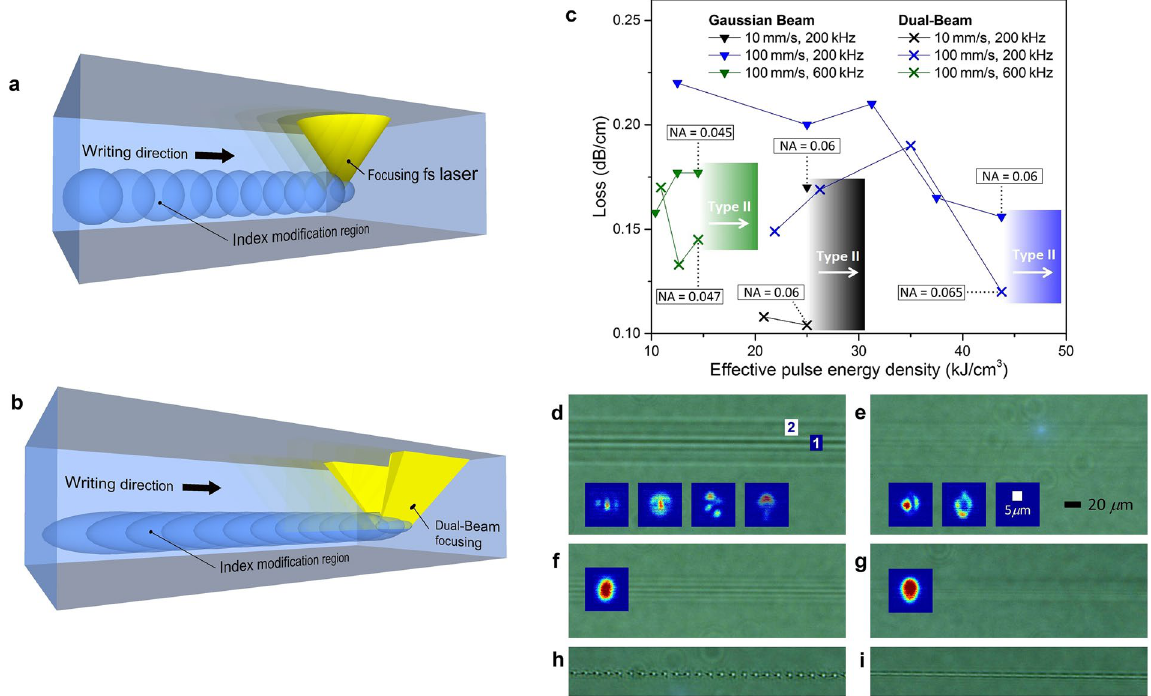
Figure 7. Lowering the propagation loss due to the waveguide interface softening using the DB technique. ( a ) Waveguide writing scheme using conventional fs-laser focusing. ( b ) Waveguide writing scheme using the Dual- Beam technique showing the softening of the waveguide interface. ( c ) Waveguide propagation loss comparison between the conventional Gaussian beam laser writing technique (triangles) and the Dual-Beam technique ( × ) with φ = 18° and θ = 25°. The three different colors represent three different recipes. Waveguide top views ( d to g ) and their respective near field mode profiles (inset images). Multimode ( d and e ) and single-mode ( f and g ) waveguides fabricated using the conventional Gaussian focusing method ( d and f ) and using the DB technique ( e and g ). The delimitation between the waveguide zone ( d1 ) and the heat affected zone ( d2 ) is more visible with the Gaussian technique. When the writing spots are too far apart, it is impossible to write functional waveguides using conventional focusing ( h ) whereas it is possible using the Dual-Beam technique ( i ) due to the elongated spots. Note that the error bars ( ± 0.03) obtained from the four measurements on every waveguide propagation loss, are not shown in the graph ( c ) in order to simplify the